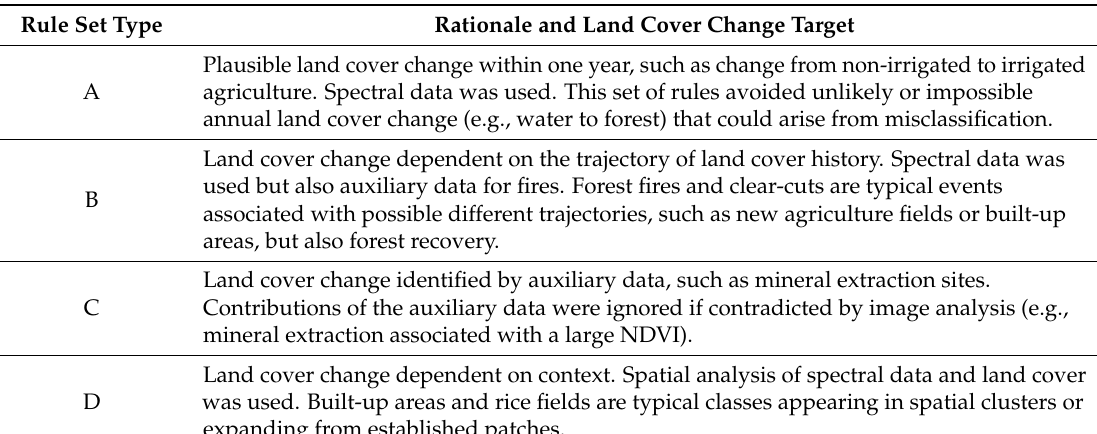
Table 5. Rule sets used for mapping are summarized as four main types (A, B, C, and D). Rule Set